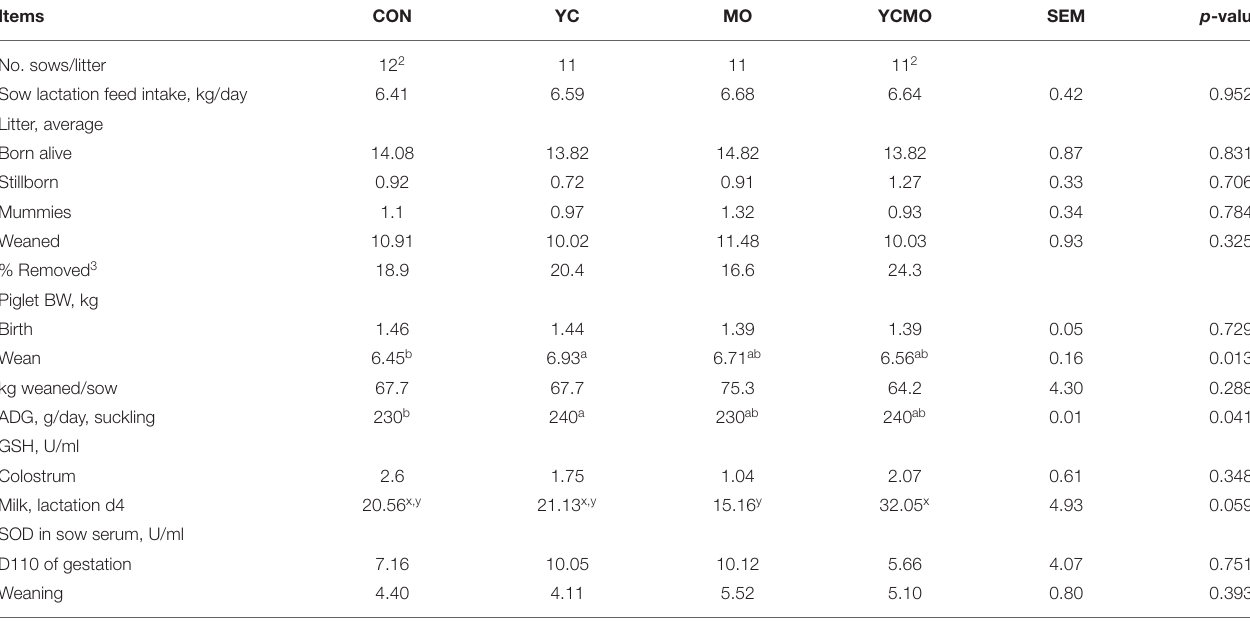
TABLE 3 | Reproductive performance, sow antioxidant status, and suckling pig performance from sows provided lactation diets with or without a whole yeast cell component (YC) and with or without peppermint oil (MO) top dress (study 1) 1,4,5 .